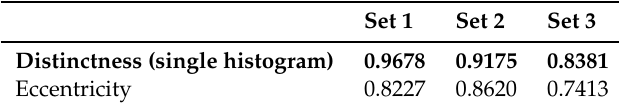
Table 6. Single histogram distinctness. For each of the three sets, the higher performance is marked as bold.